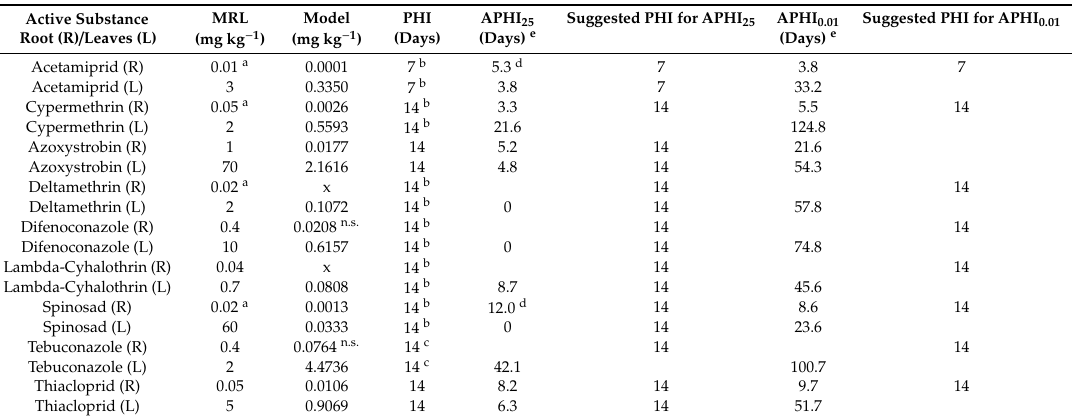
Table 5. Pesticide residues in